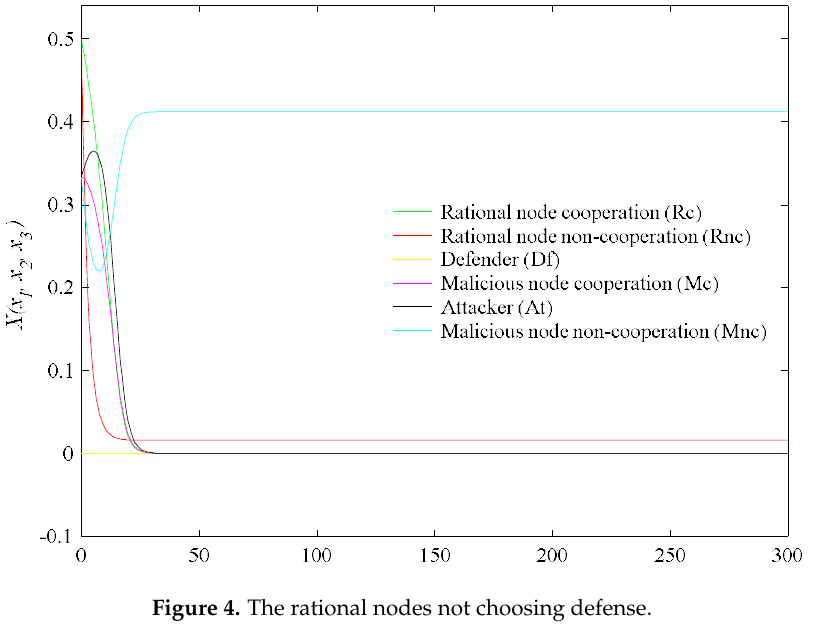
Figure 4. The rational nodes not choosing defense.